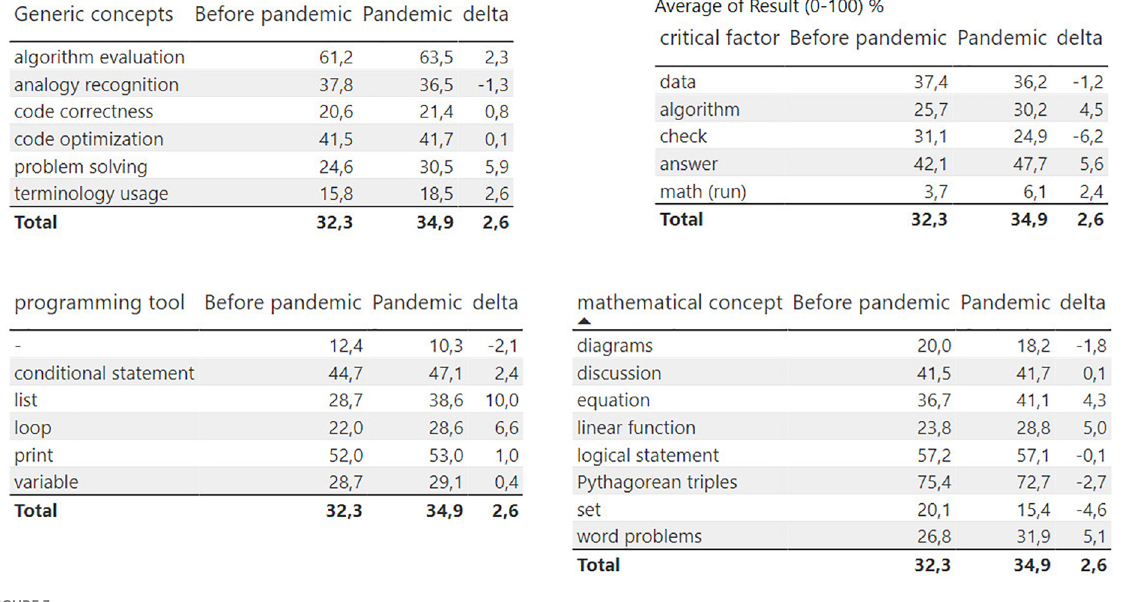
FIGURE3 Average results by the main characteristics.